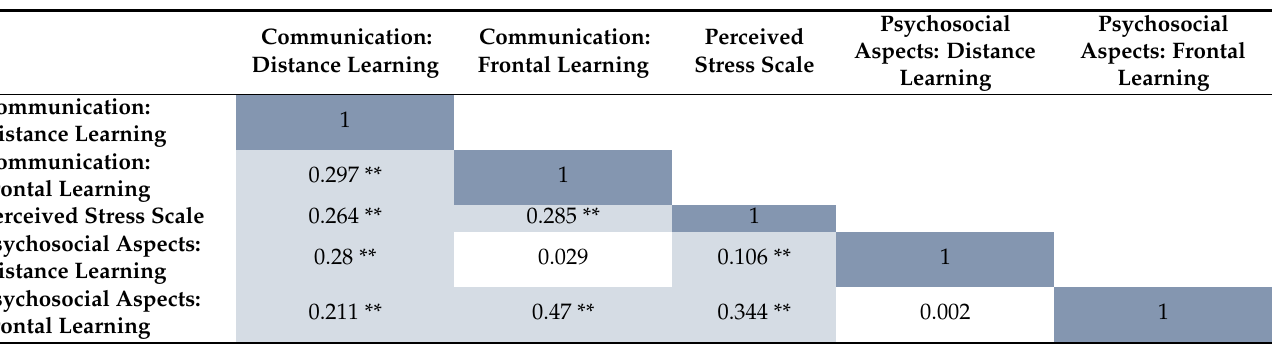
Table 4. Correlation matrix between all variable indices.